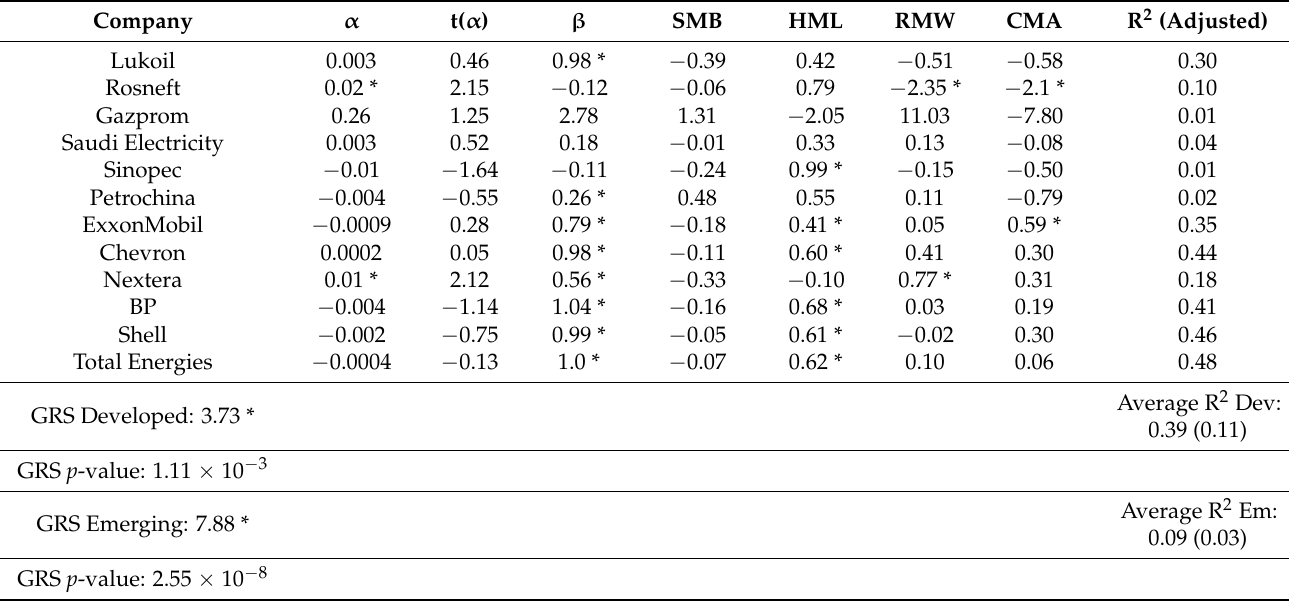
Table 2. Fama-French Five-Factor Regression Results for Leading Energy Companies, * p < 0.05; standard deviation on mean values in